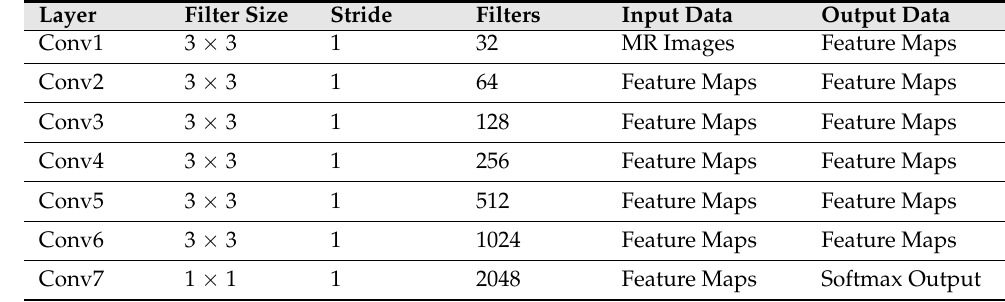
Table 8. Architecture of Convolutional Layers with Input and Output Data.